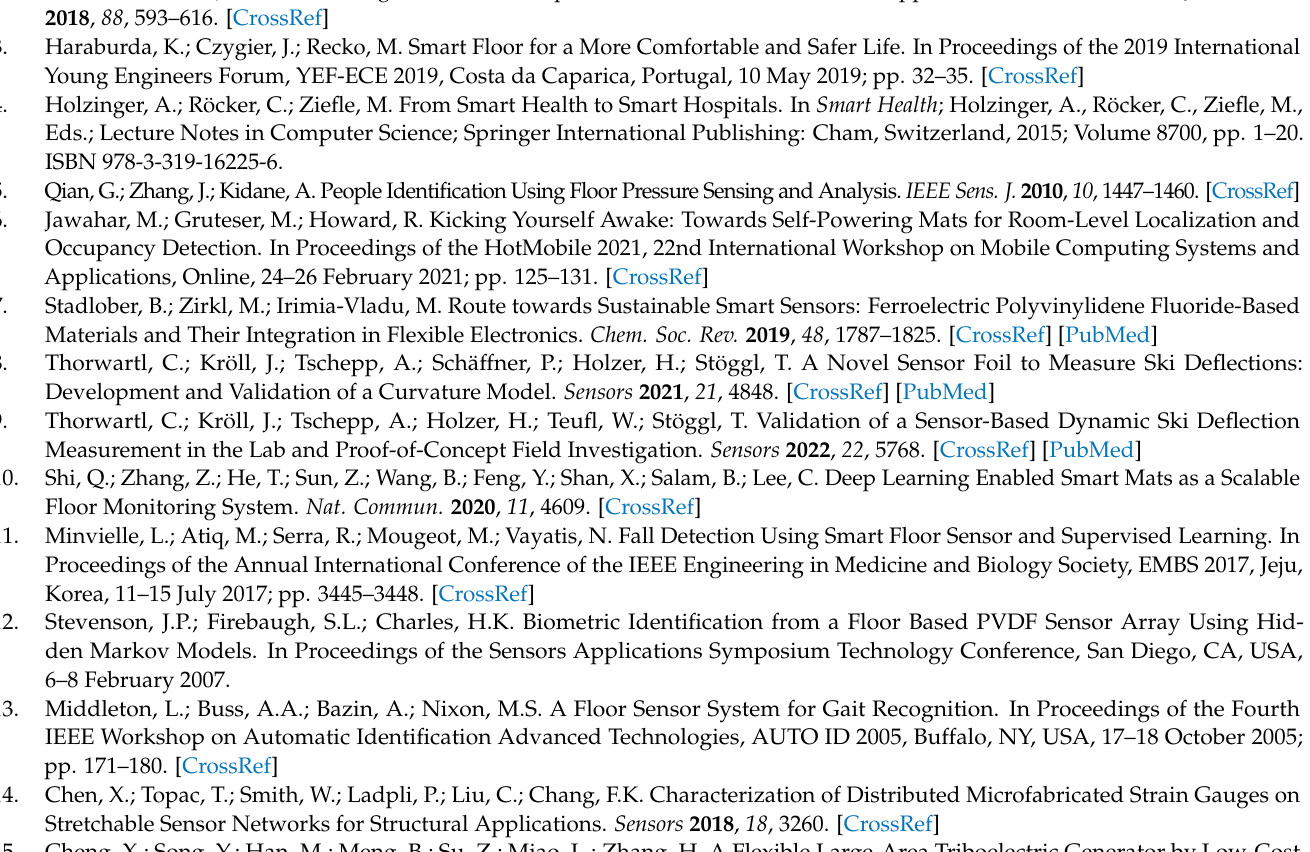
and tensile test results, Figure S3: FEM model meshing, Figure S4: d33 measurement details, Video S1: Sweep with roller, Video S2: sweep with finger, Video S3: Sweep with hand, Video S4: Impact of roller on